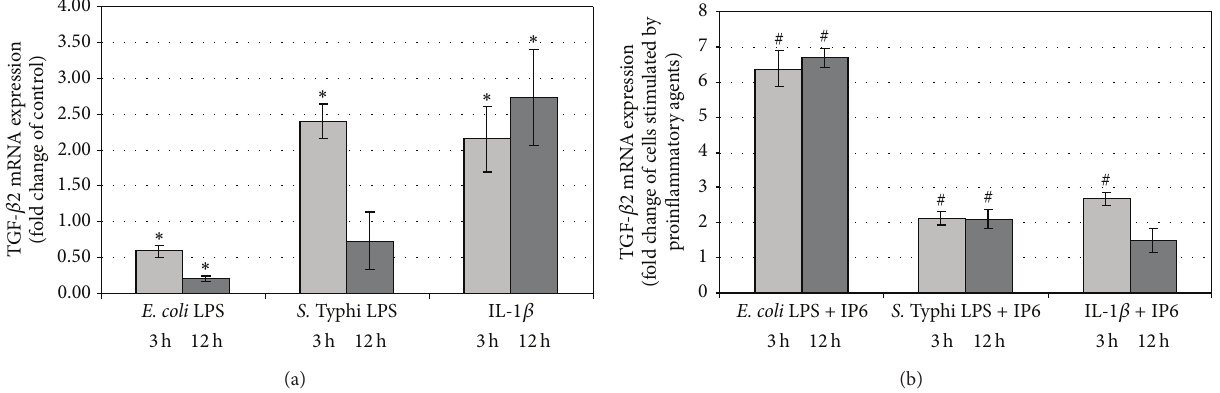
Figure 2: Expression of TGF- 𝛽 2 gene in Caco-2 cells as determined by real-time RT-PCR. Changes in TGF- 𝛽 2 mRNA expression in Caco- 2 cells after treatment with (a) proinflammatory agents and (b) proinflammatory agents and 2.5mM IP6 for 3 h and 12h. The results are presented as mean ± SD of three separate experiments; ∗ 𝑃 < 0.05 versus Caco-2 cells; # 𝑃 < 0.05 versus proinflammatory agents-stimulated